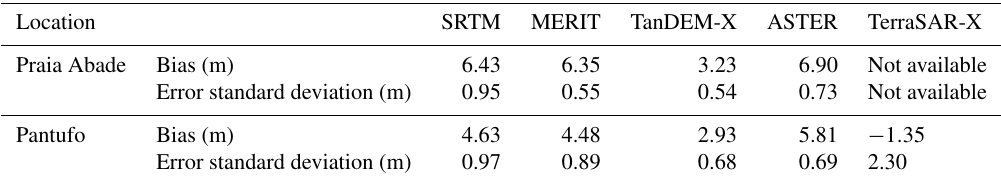
Table 6. Error metrics of the studied publicly available DEMs for the two locations. The bias and error standard deviation from the UAV- derived DEM for SRTM, MERIT, TanDEM-X, ASTER and TerraSAR-X, in Praia Abade and Pantufo.